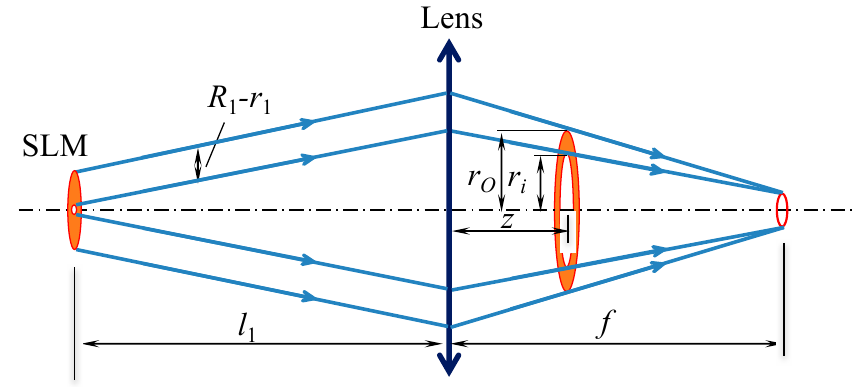
Figure 9. The principle of the annular beams focused by a lens.